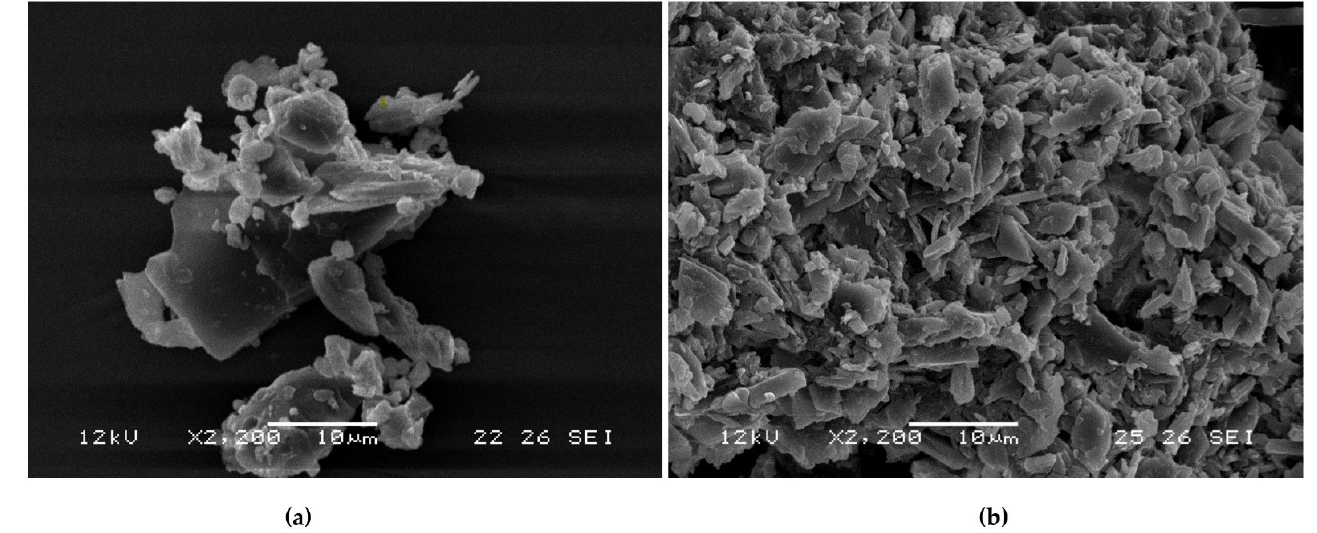
Figure 5. SEM images of ( a ) β -cyclodextrin and ( b ) [ β -cyclodextrin:catnip oil] inclusion complex.